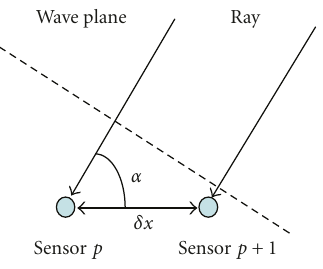
Figure 3: Phase o ff set between two